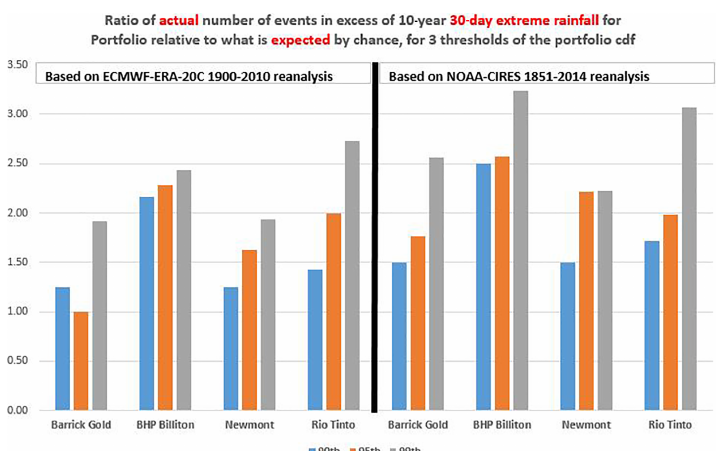
Figure C4. Ratio of the actual number of the number of 10-year, 30-day extreme rainfall events fitting the four portfolio relative to what is expected by chance, for three thresholds of the portfolio